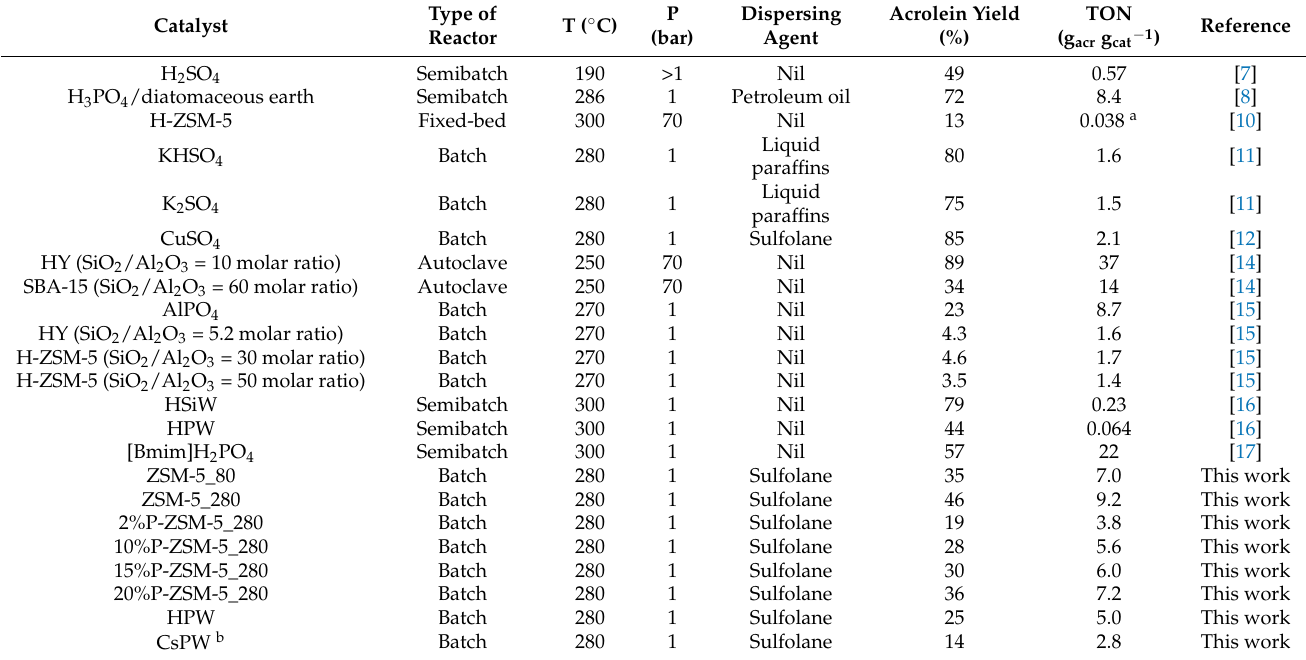
Table 1. Catalytic studies of ZSM-5-based materials, heteropolyacids and some representative acidic materials in liquid-phase dehydration of